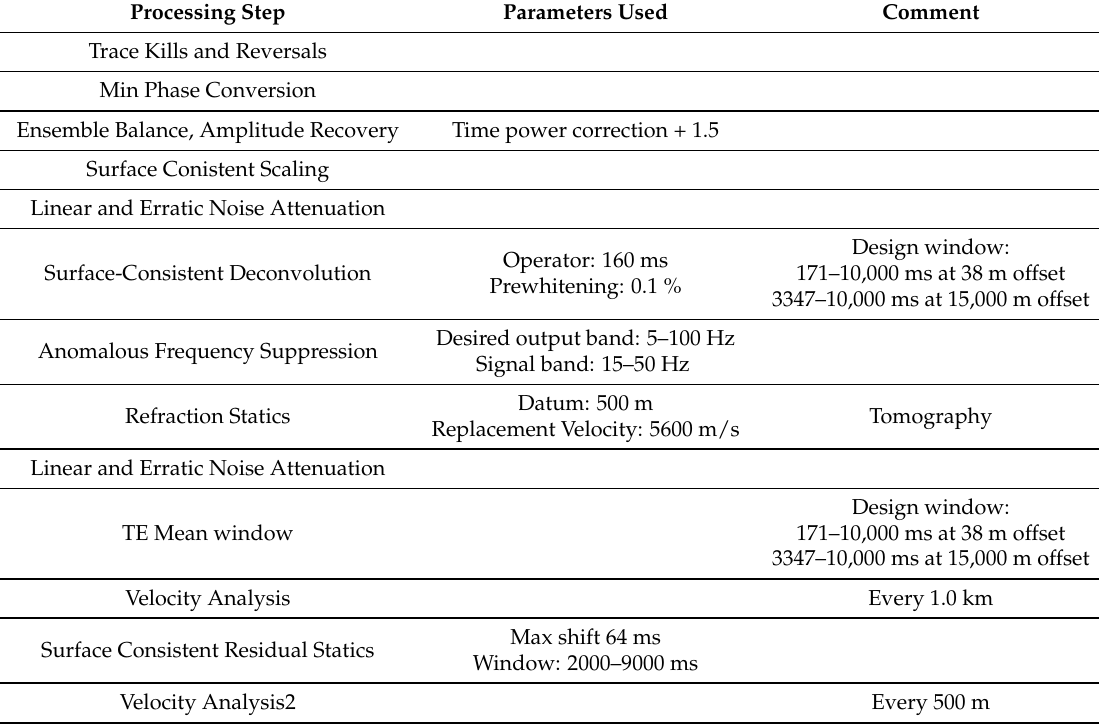
Table 3. Seismic data processing streams used for Metal Earth